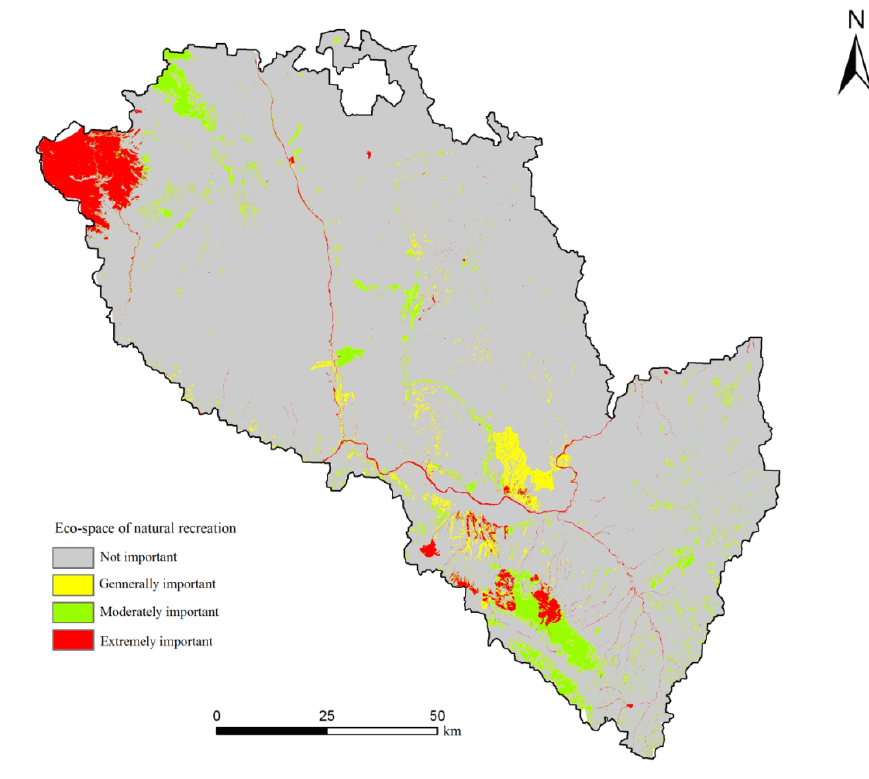
Figure 7. Evaluation results of natural recreation importance in Lanzhou City.